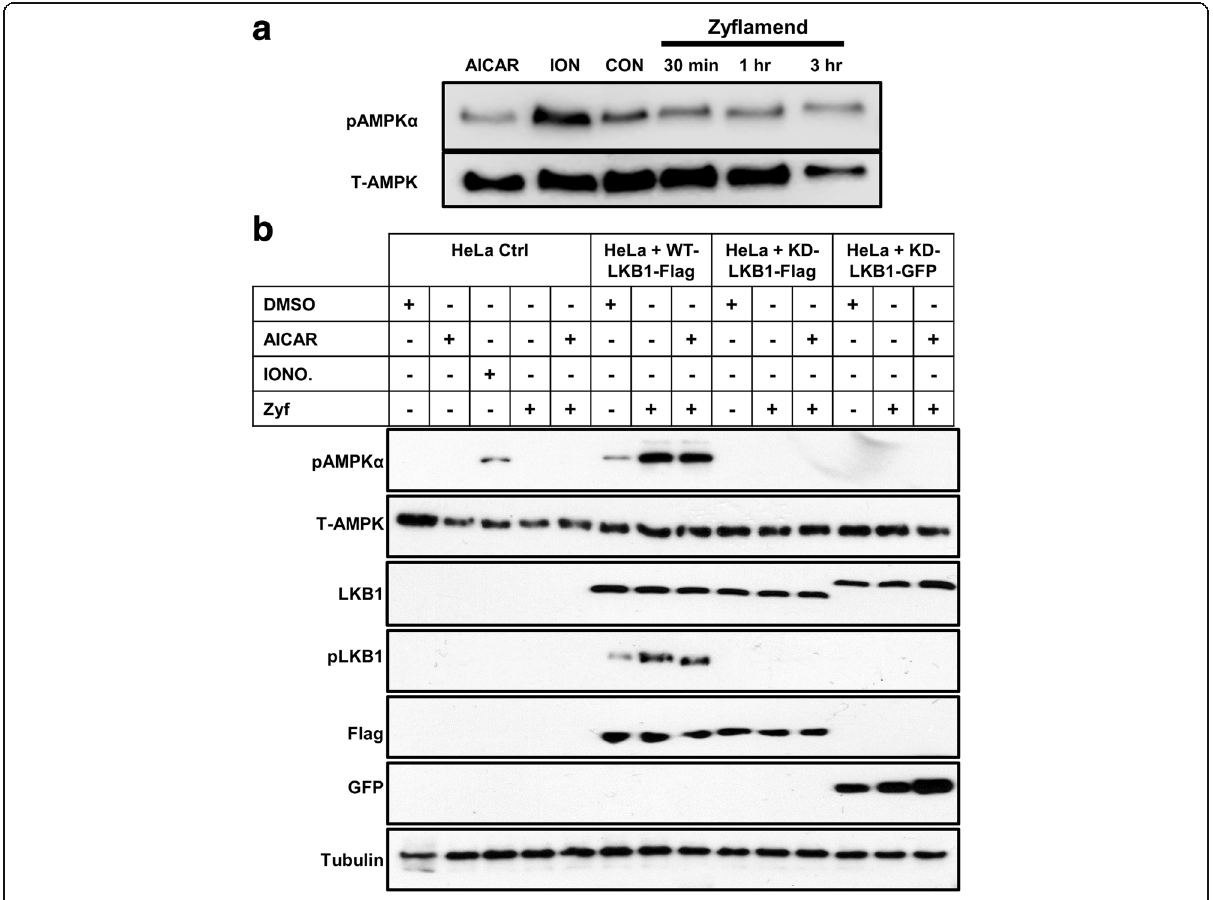
Fig. 6 Effects of Zyflamend on pAMPK (at Thr172) and pLKB1 (at Ser428) in HeLa cells null for LKB1, transfected with wild type (WT) LKB1 or with two catalytically dead (KD) mutants of LKB1. a Western blot of pAMPK in HeLa cells ± AICAR, (1 mM, 1 h), ionomycin (1 μ M, 1 h) or Zyflamend (200 μ g/mL, 30 min – 3 h). ( b ) Western blot of pAMPK in HeLa cells, WT-LKB1 HeLa cells, and KD-LKB1 HeLa cells ± AICAR (1 mM, 1 h), ionomycin (1 μ M, 1 h), and/or Zyflamend (200 μ g/mL, 1 h). Representative immunoblots from 3 independent experiments are shown. Abbreviations: Con, Control; DMSO, dimethyl sulfoxide; Ion, ionomycin; Zyf,